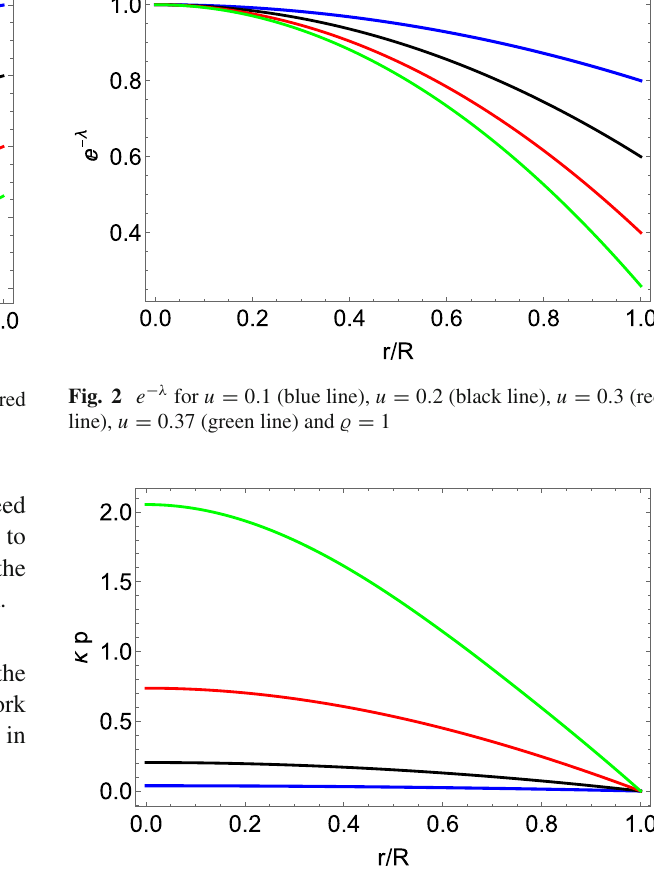
Fig. 3 p for u = 0 . 1 (blue line), u = 0 . 2 (black line), u = 0 . 3 (red line), u = 0 . 37 (green line) and (cid:13) = 1